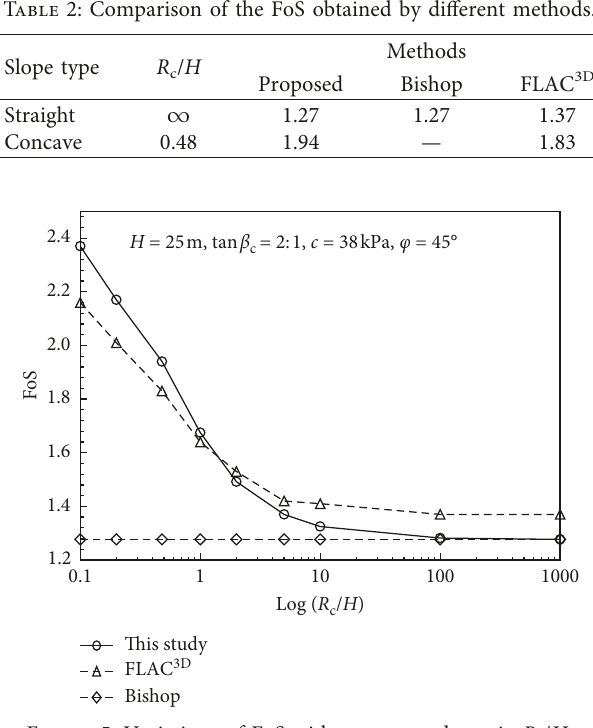
Figure 5: Variations of FoS with respect to the ratio R